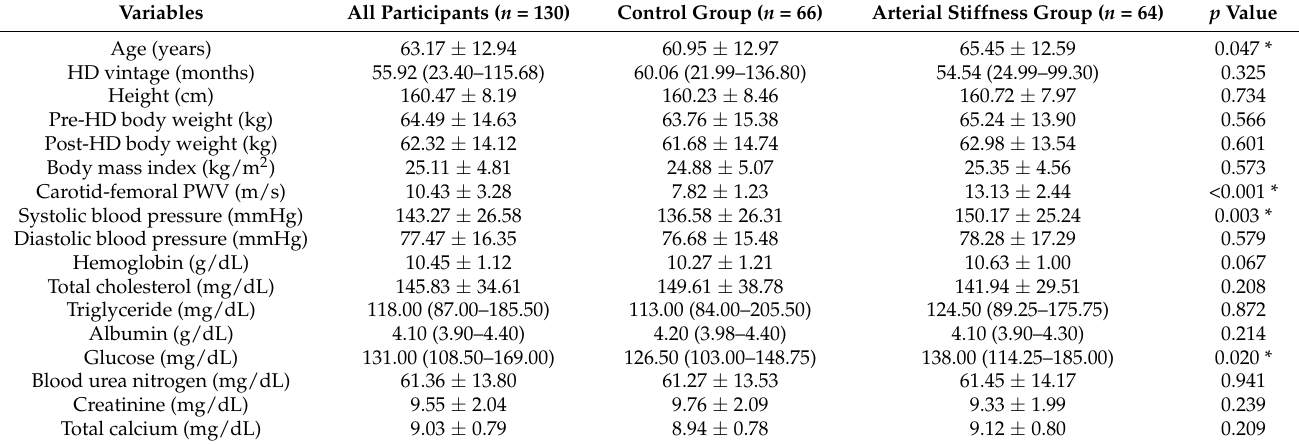
Table 1. Clinical variables of arterial stiffness group or control